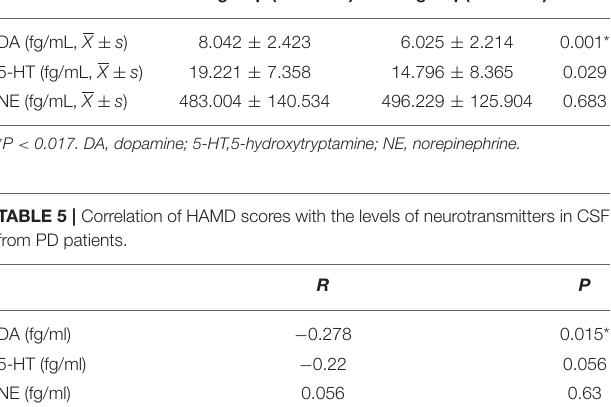
TABLE 4 | Levels of neurotransmitters in CSF from PD-D and PD-ND groups. PD-ND group (24 cases) PD-D group(52 cases)